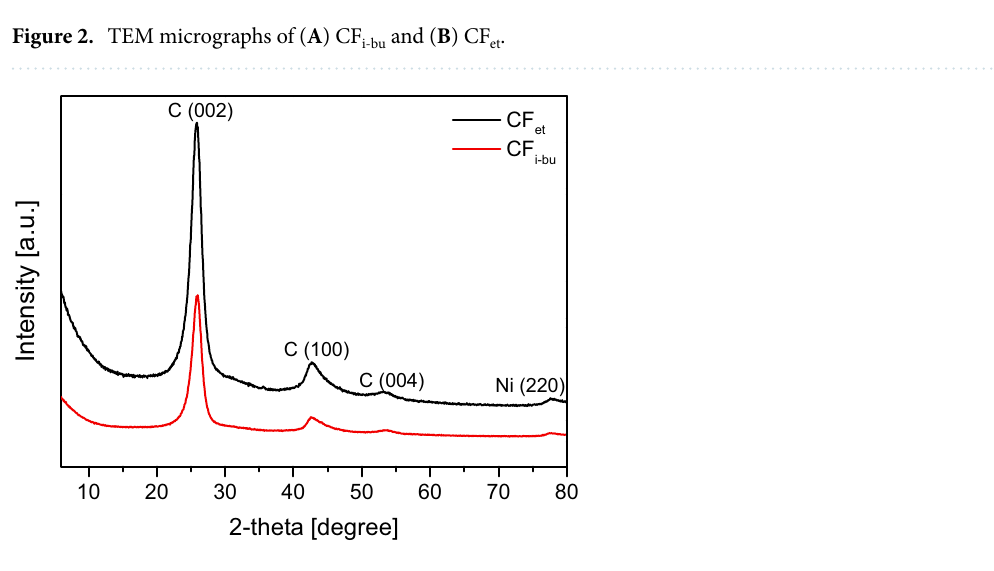
Figure 3. The XRD patterns of the prepared initial CF